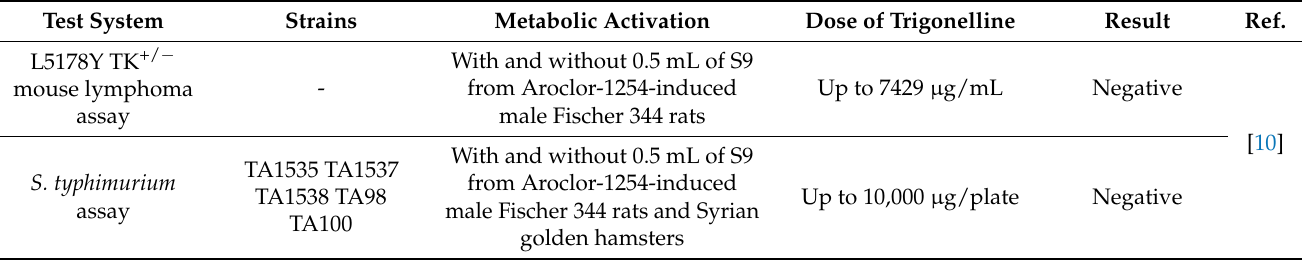
Table 4. Results for trigonelline in different genotoxicity and mutagenicity test systems. Test